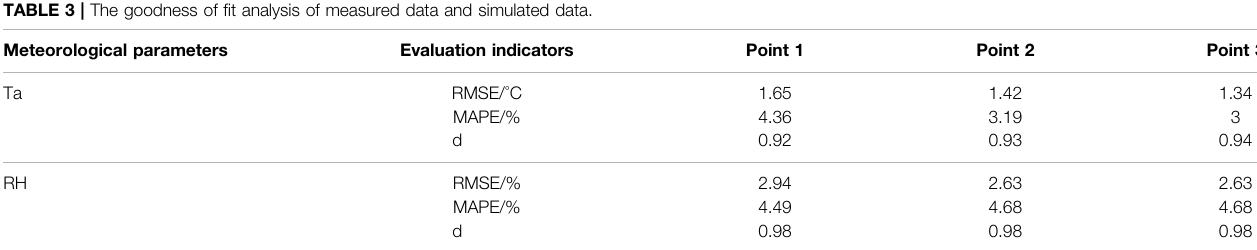
Table 5 shows the Pearson correlation coef fi cient (r) between greening rate and simulated data within different buffer radiuses. Within a radius of 10m, the greening rate is signi fi cantly correlated with PET value but has no signi fi cant